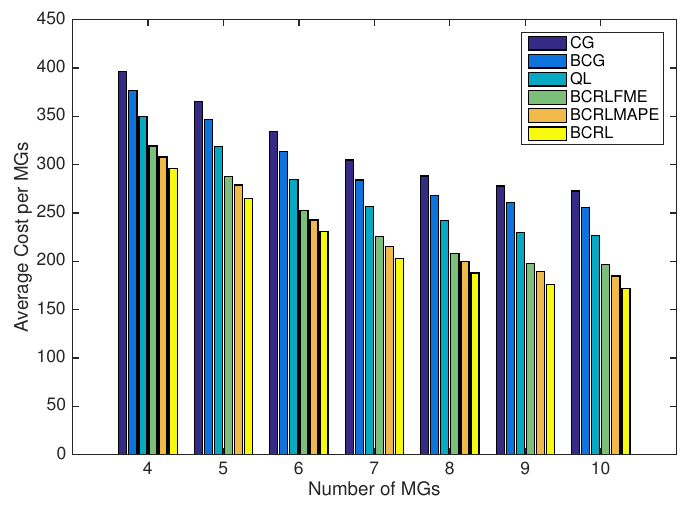
Figure 2. Average cost versus number of microgrids.